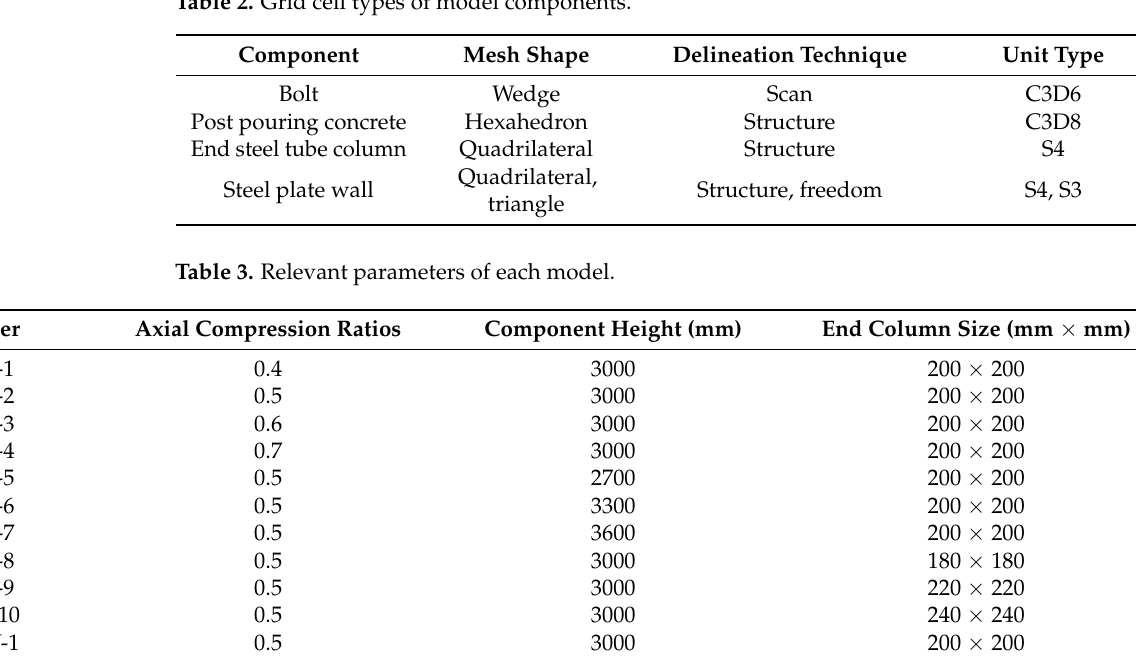
Figure 6. Diagrammatic drawing simulation of boundary conditions. ( a ) Bottom simulation com- pletely fixed. ( b ) Top simulation applies axial and shear forces. Table 2. Grid cell types of model components.